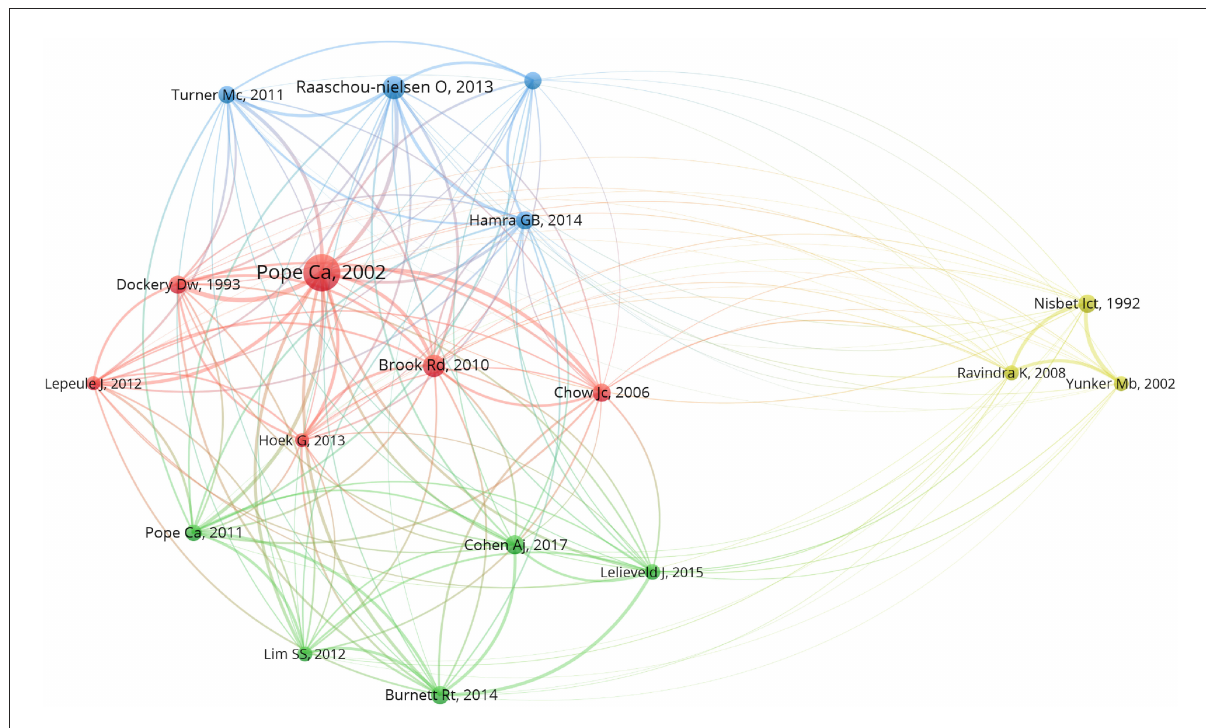
FIGURE6 Network map of 18 most co-cited